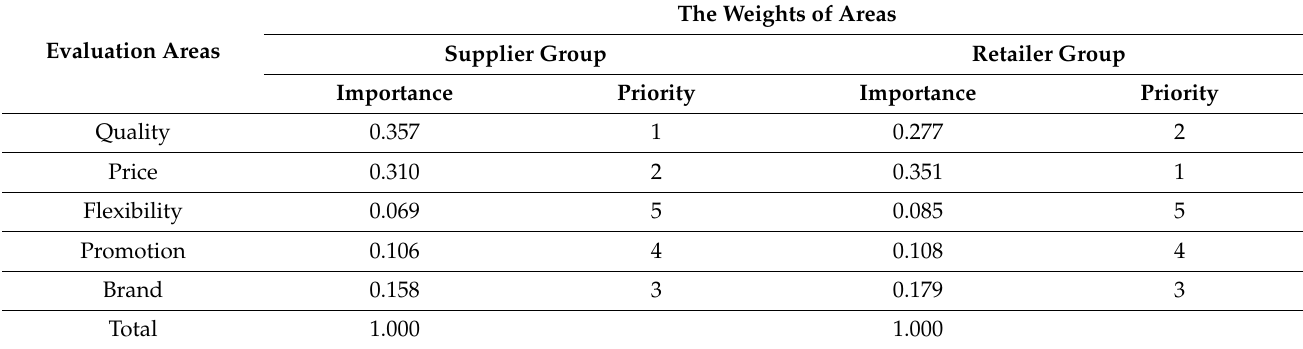
Table 5. Comparison analysis result on evaluation areas.